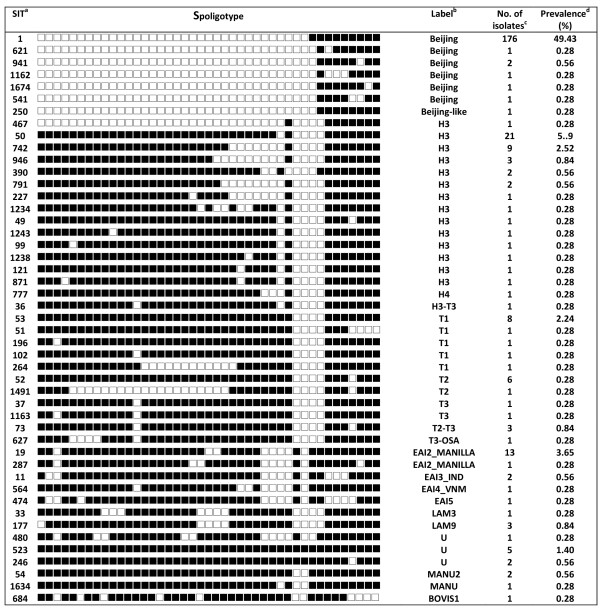
Spoligotypes of 290 isolates with a shared international type (SIT) number in SpolDB4. a Shared international type (SIT), international spoligotype database SpolDB4 . b Label representing spoligotype families as assigned in the international spoligotype database SpolDB4. c Number of isolates in this study. d Prevalence, representing the number of isolates with a common SIT relative to the total number of isolates from the same database (356) classified by SIT from Tri-Service General Hospital (expressed as a percentile).